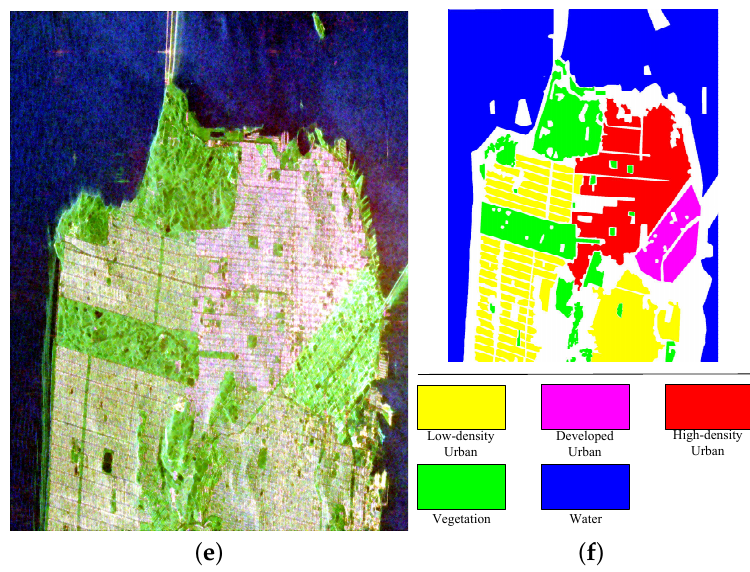
Figure 3. Three fully polarimetric images: ( a ) PauliRGB image of Xi’an area; ( b ) Ground truth of Xi’an area image; ( c ) PauliRGB image of Flevoland; ( d ) Ground truth of Flevoland image; ( e ) PauliRGB image of San Francisco Bay; and ( f ) Ground truth of San Francisco Bay